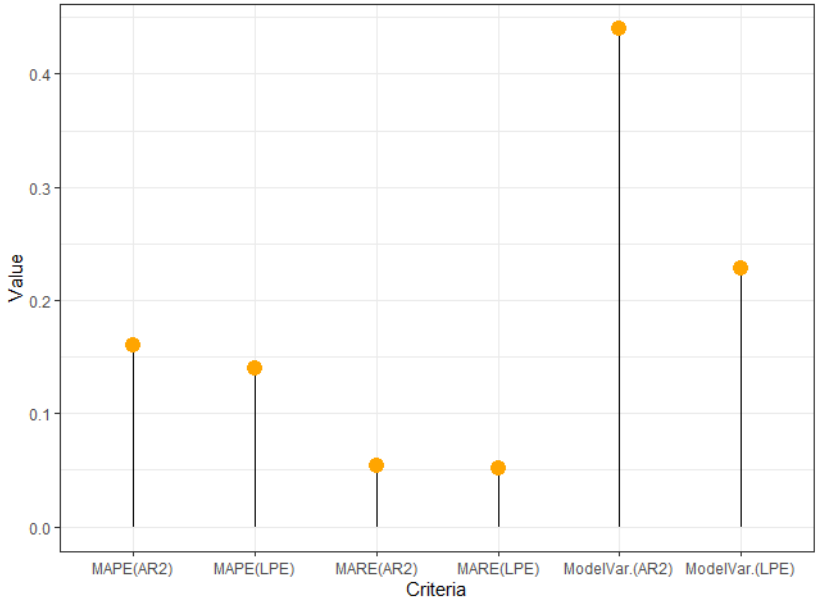
Figure 3. Bar graph representation of the values in Table 3.